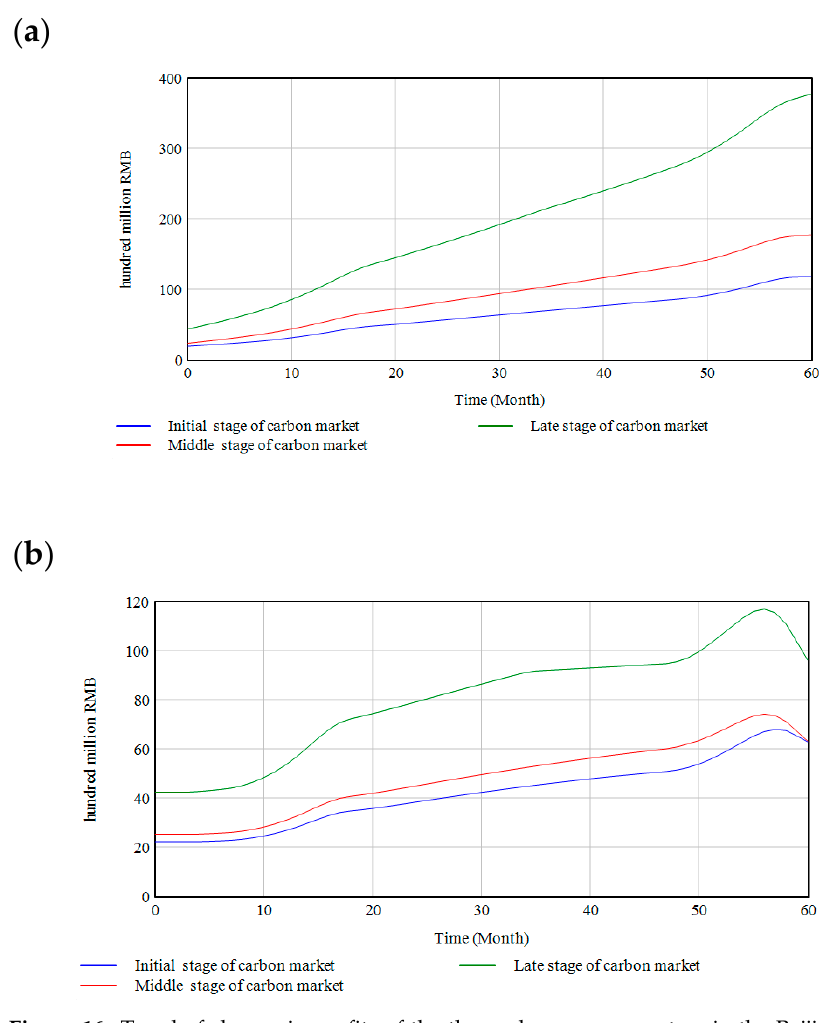
Figure 16. Trend of change in profits of the thermal power generators in the Beijing–Tianjin–Hebei region. ( a ) Change trend of carbon quota sellers’ profit; ( b ) Change trend of carbon quota buyers' profit.